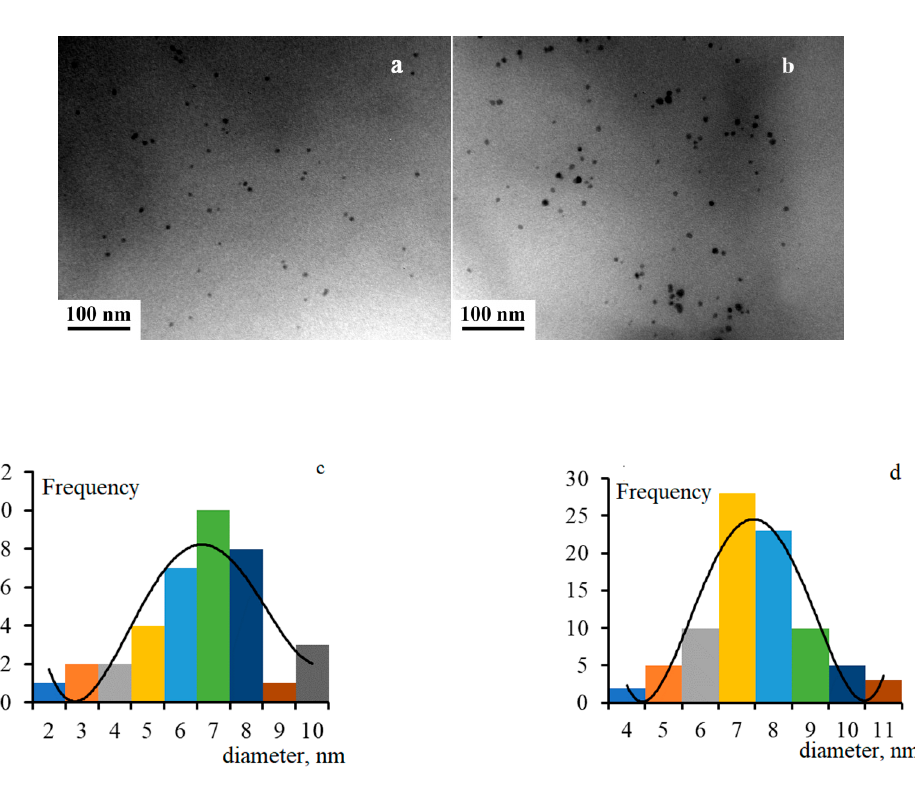
Figure 2. Microscopic image of the nanocomposite with 10 wt.% Pd ( a ) and 20 wt.% Pd ( b ) and their size distribution ( c , d , respectively).